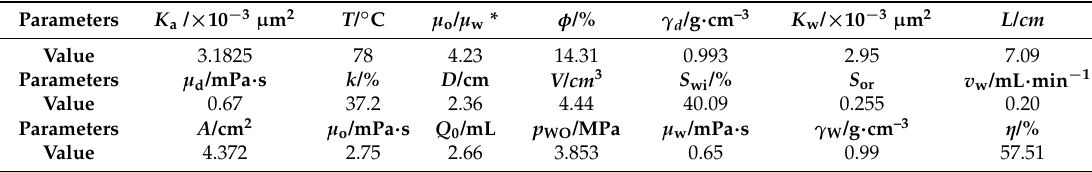
Table 9. The Core 31 physical property parameters and experimental conditions.